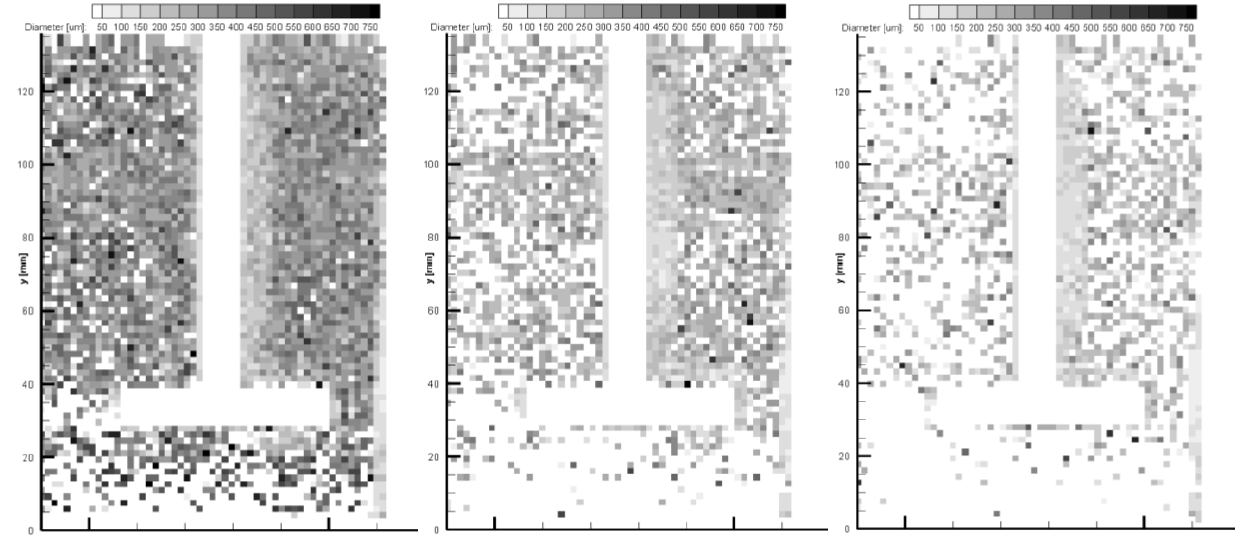
Fig. 9. Spatial distribution of particle size of Rhodosil Oil 47V50 of stirrer rate 540